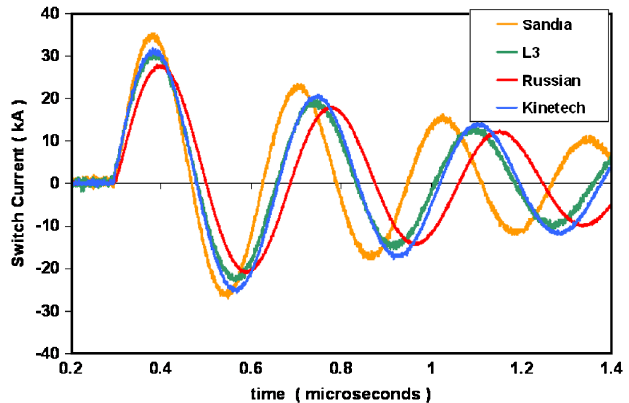
FIG. 14. (Color) Short-circuit current waveforms for our brick with 38 nF capacitors for the four switches we tested. The capacitors were charged to (cid:2) 60 kV for these